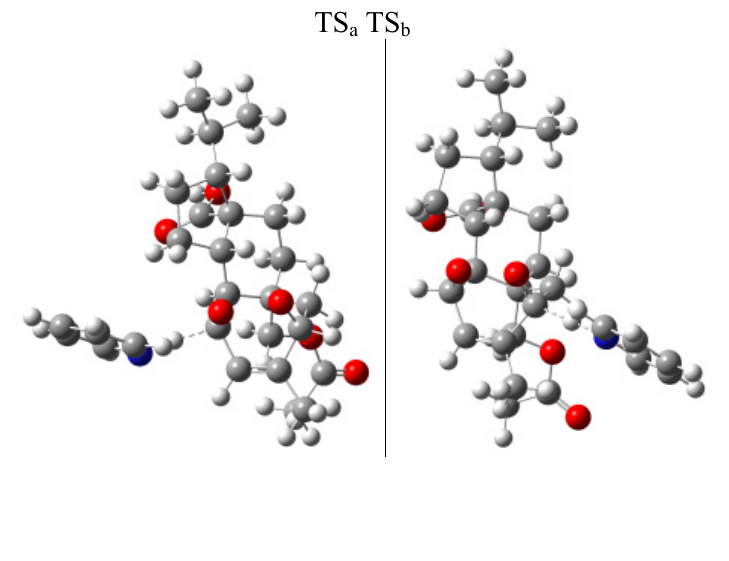
Figure 5. Transition states (TS 09) [19] for the reaction between mulinane 3 and pyridine leading to compounds 1 and 2